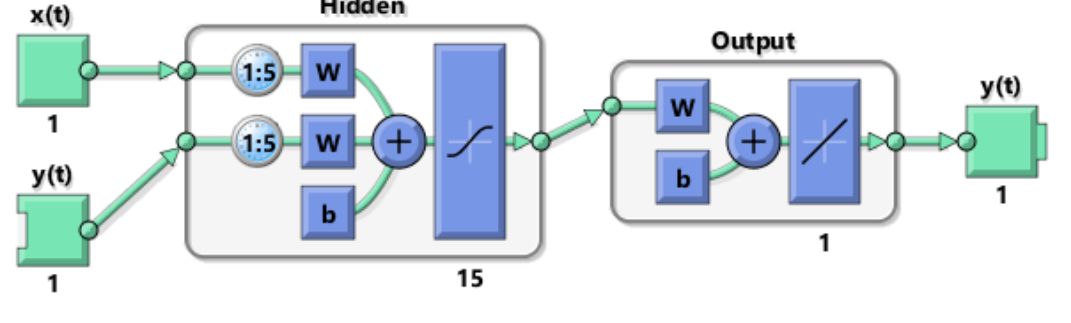
Figure 13. Identification network. Table 6. Mean Squared Error (MSE) after